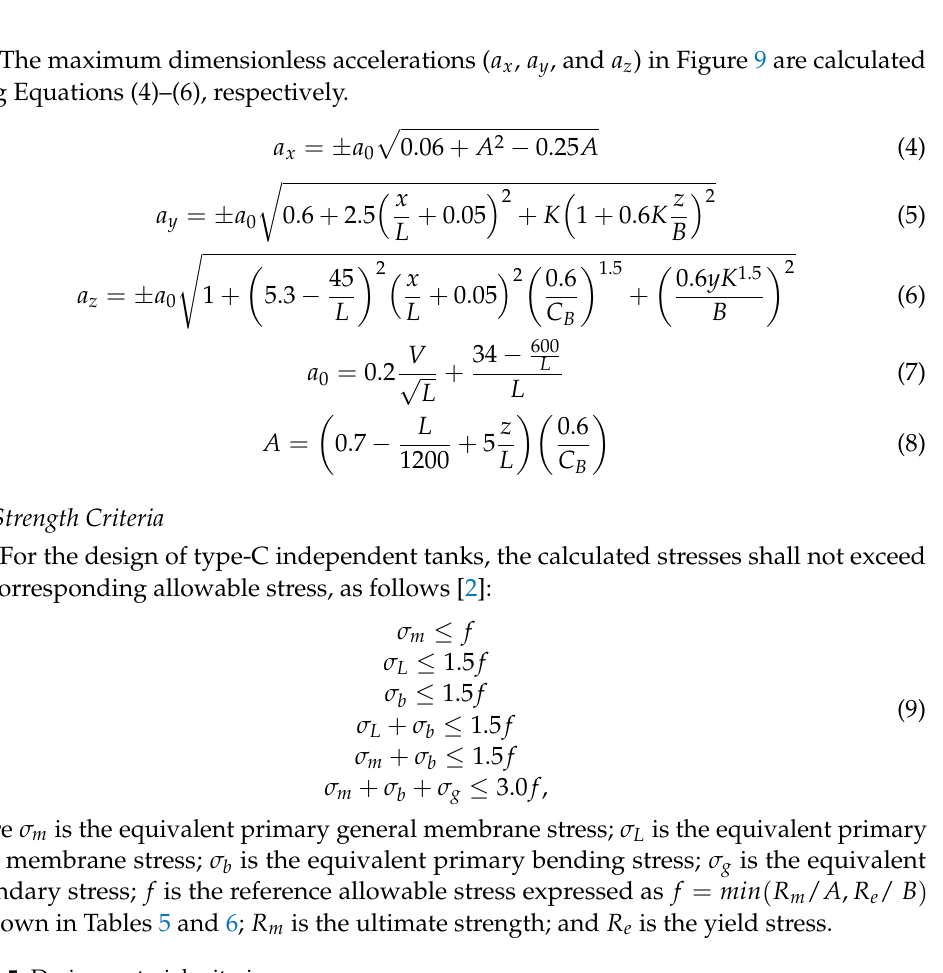
Table 5. Design material criteria.